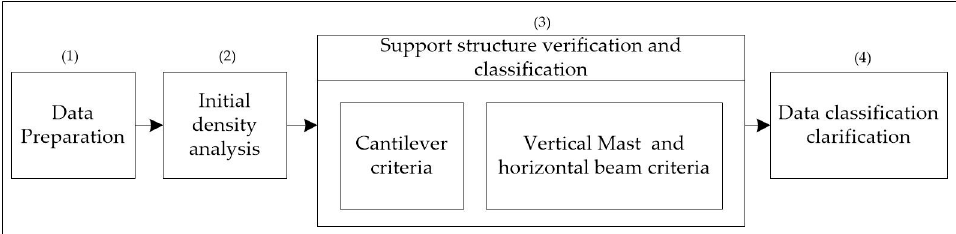
Figure 5. The simplified algorithm structure.